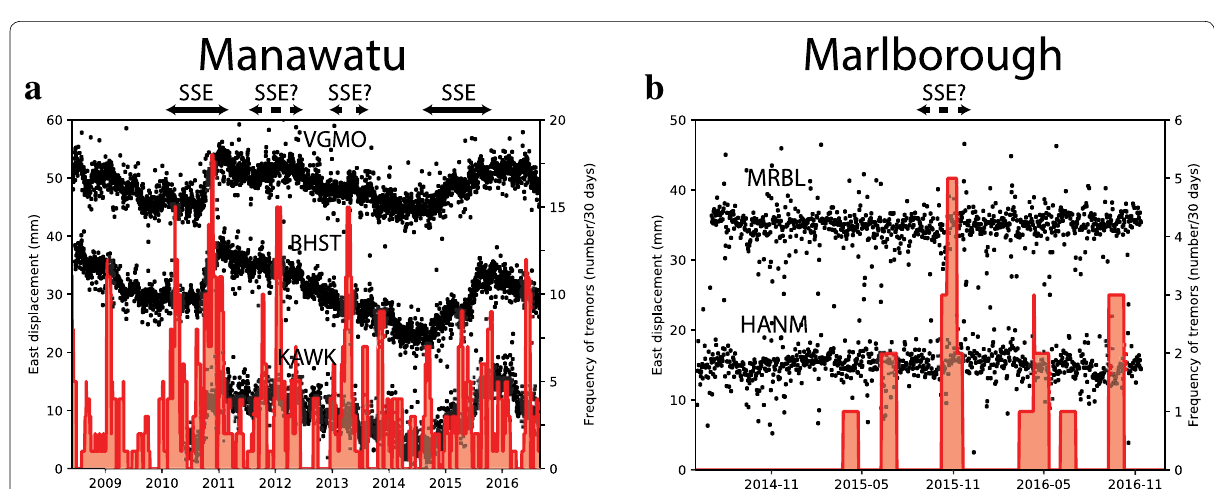
Fig. 5 Tremor density and GPS displacement plots in: a Manawatu and b Marlborough. The tremor density (red bars) is based on a 30-day moving window. The GPS displacements consist of the detrended daily eastward displacements (black circles) at the GeoNet GPS stations in each region. Some of the known SSEs (2010–2011 and 2015–2016) appear to be related to an increase in tremor